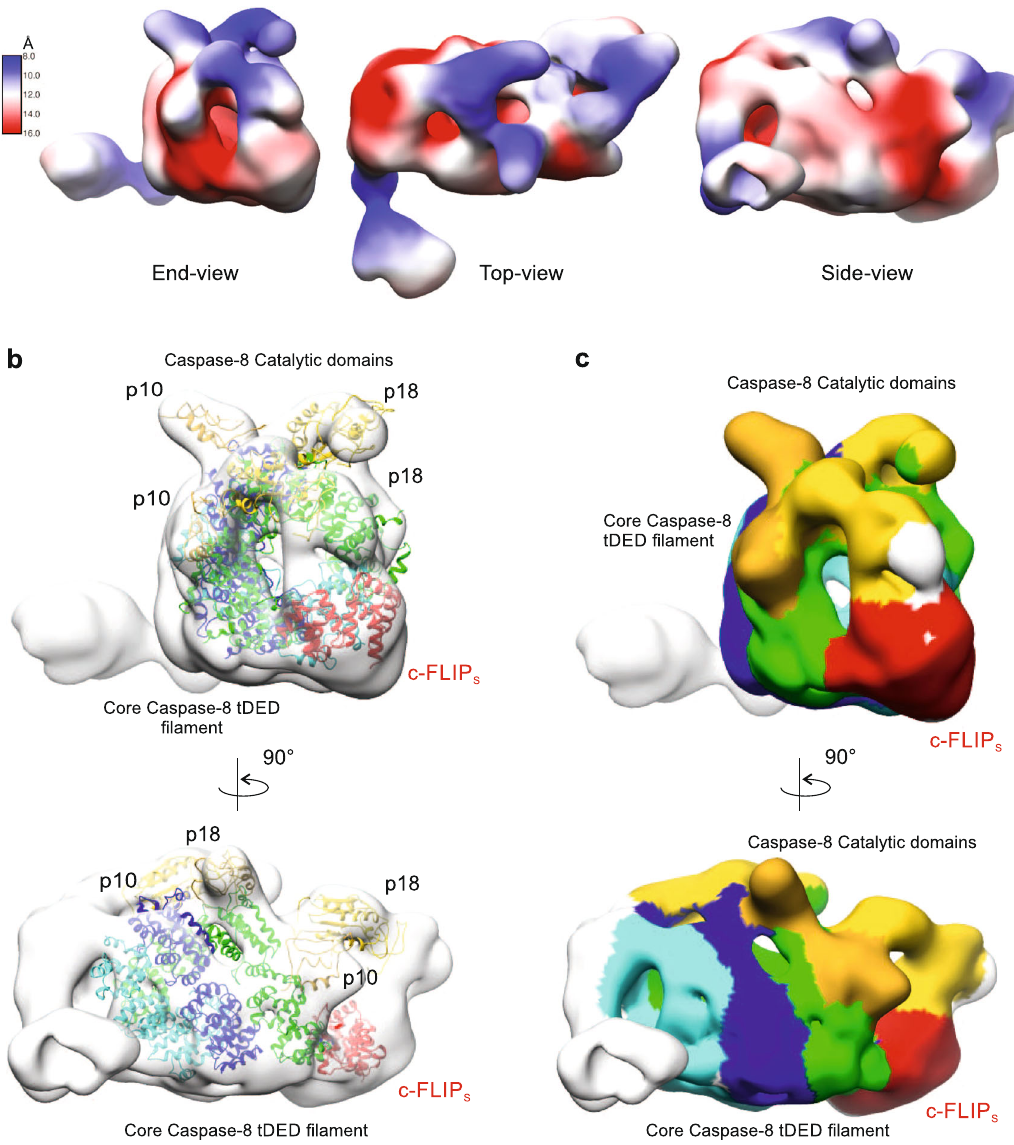
Fig. 7 Binding of c-FLIP S prevents Caspase-8 catalytic domain dimerization. a Analysis of local resolution of 3D re fi ned Cryo-EM map of FADD:full-length Caspase-8:FLAG-c-FLIP S complex. b Re fi ned map with published tDED-only structure (5L08; 12 ) and the p18 and p10 subunits of the intact catalytic domain dimer (modeled on NMR-based structure, 2k7z; 21 ), fi tted as a rigid body relative to the Caspase-8 fi lament. c EM volume of Caspase-8 DEDs, c-FLIP S (red) and catalytic domain assembly. Each strand of the DED helix is coloured; tDEDs in blue and dark green strands are aligned, whereas tDEDs in the cyan strand are offset. Catalytic domains are coloured gold or yellow and from their positioning within the EM map have not formed a canonical catalytic